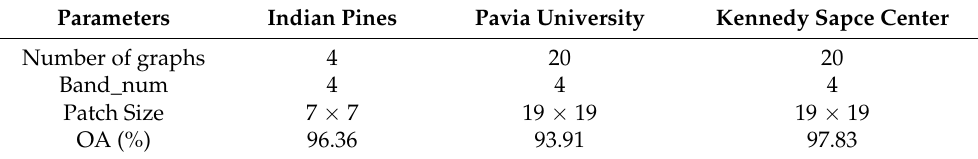
Table 4. The parameter settings of the random multi-graph algorithm on the three datasets. Parameters